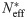
Distributions of the characteristic abundance Neff* of surviving species, compared with the theoretical prediction for maximal diversity, showing that the lower diversity in simulations is mostly due to losing species with lowest Neff* (leftmost bin).Reducing Nc (increasing population size) affects diversity mainly by allowing these “rare” species to persist.